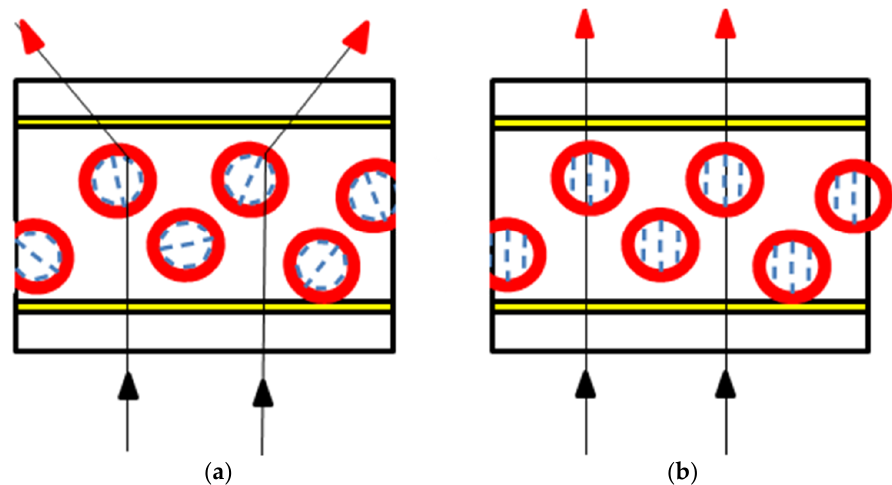
Figure 5. Switching behavior of our color PDLCs with a core–shell structure. ( a ) When no voltage is applied, the encapsulated liquid crystals with a color shell are dispersed in the polymer matrix. The liquid crystal molecules in the droplet assume a bipolar or radial configuration depending on the interaction characteristics, which causes the light scattering. ( b ) By contrast, when a voltage is applied, the liquid crystal molecules are oriented in parallel to the electric field. In this state, light is transmitted by minimizing the scattering as the ordinary refractive index of the liquid crystal and the refractive index of polymer are nearly identical.